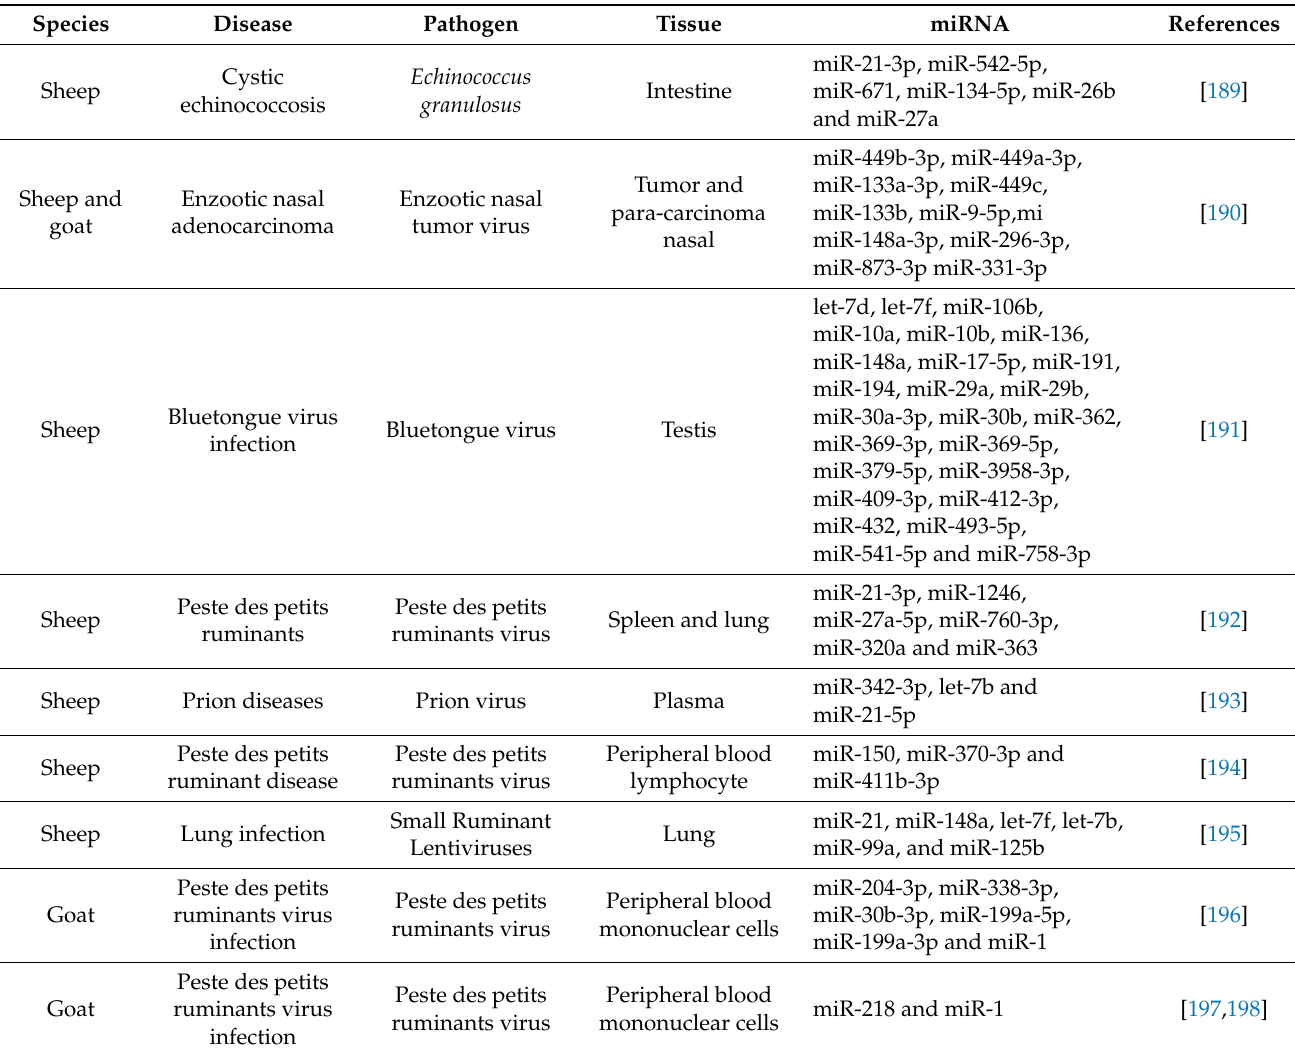
Table 5. miRNAs with important roles in small ruminant